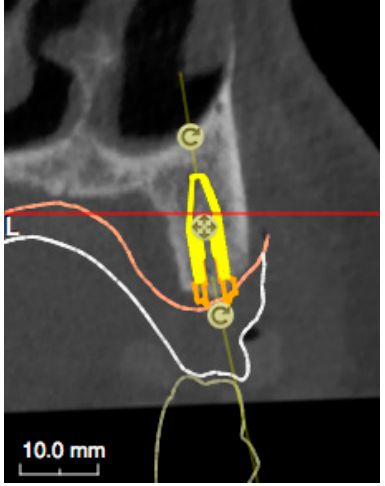
Figure 6. Virtual positioning of the implants, based on the aesthetic prosthetic project.